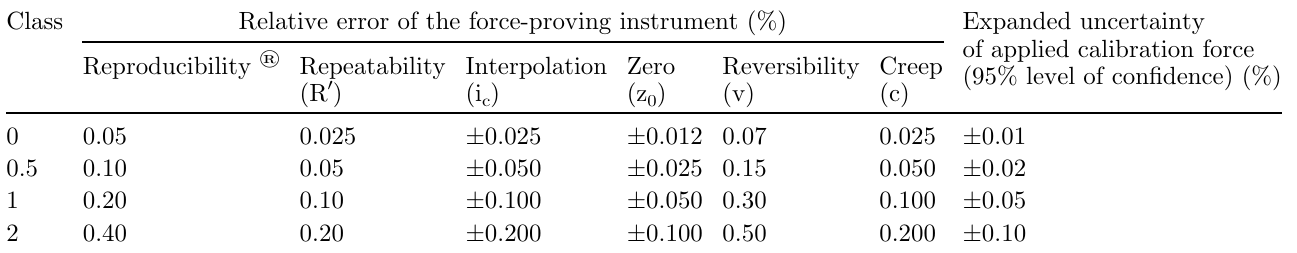
Table 1. Classi fi cation criteria mentioned in ISO 376:2011. Class Relative error of the force-proving instrument